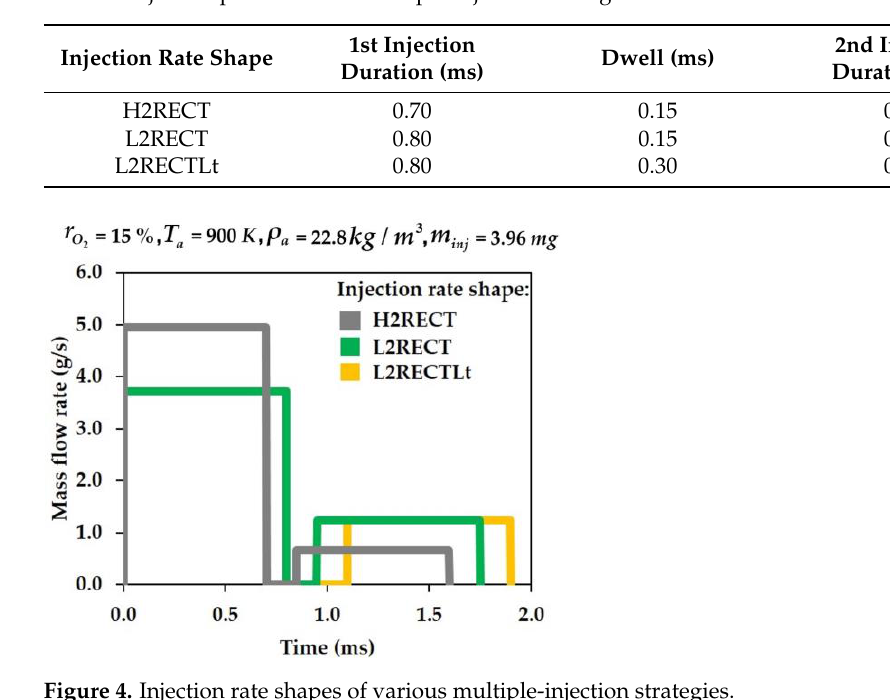
Figure 4. Injection rate shapes of various multiple-injection strategies.